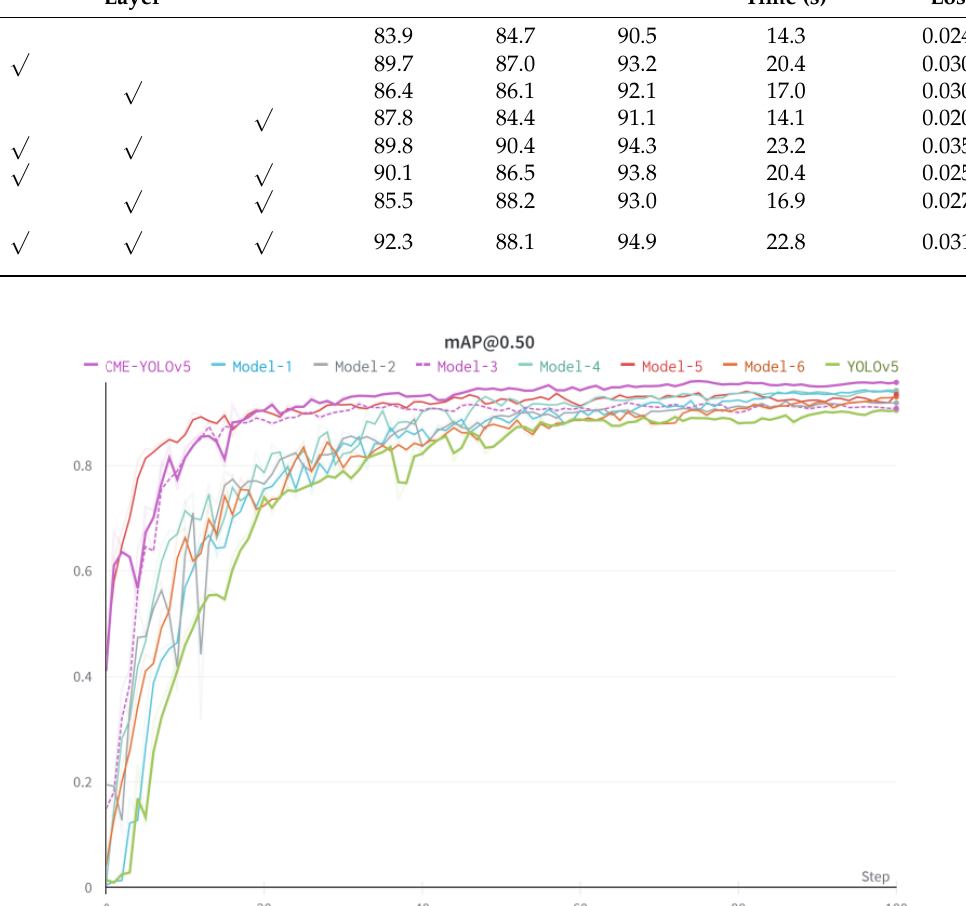
Figure 3. mAP@0.50 of the ablation experiment.